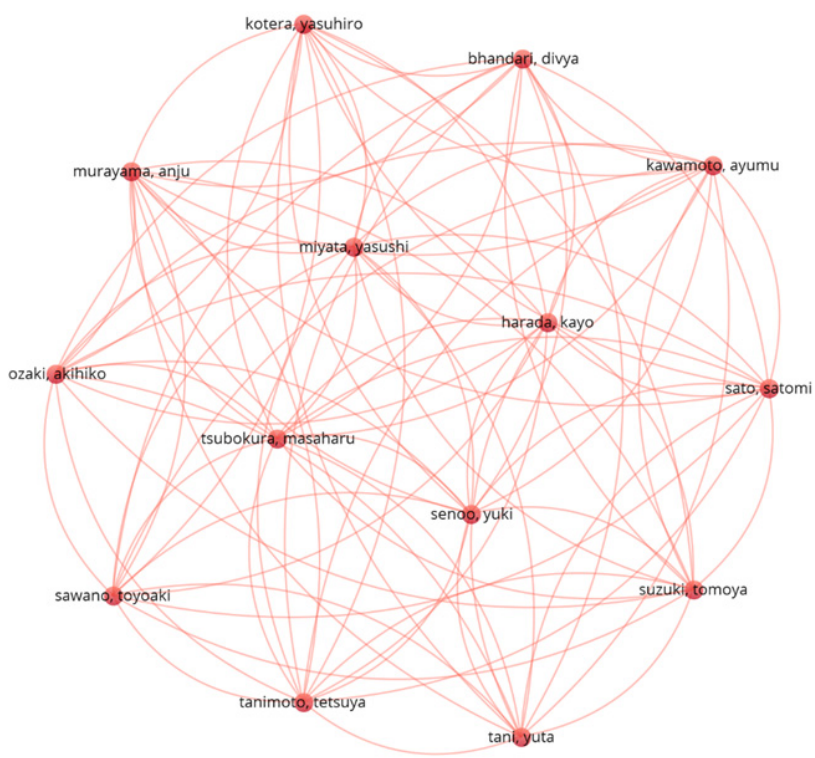
Figure 2. VOSviewer mapping of student perceptions of online education regarding co-authorship. Source: authors’ own analysis with VOSviewer.